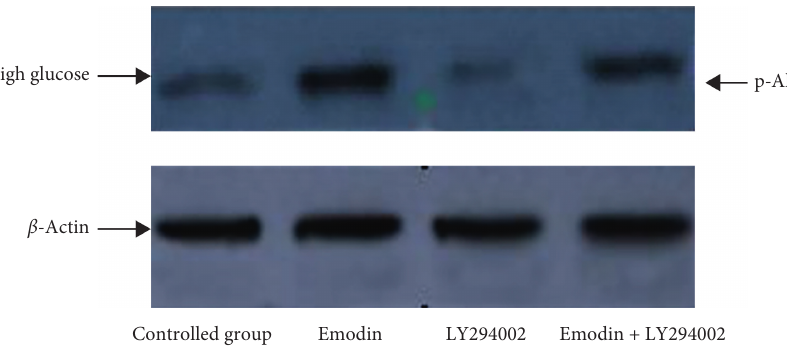
Figure 1: p-Akt protein